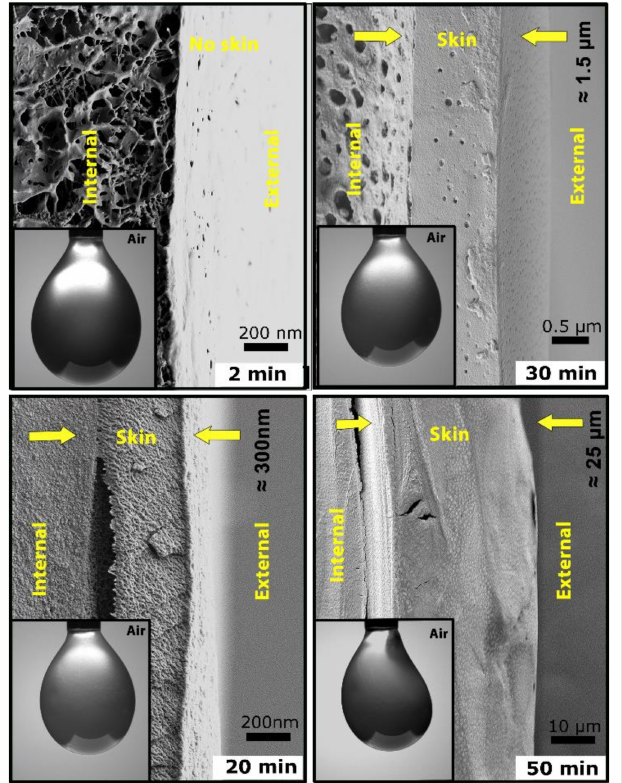
Figure 2. Self-assembly and evolution of skin at the water–air interface. SEM images of the cross- section of the pendant droplets of 2% w / v silk solution after 2 min, 20 min, 30 min, and 50 min. The skin layer is indicated in-between two yellow arrows for all images. For each time point, we have also included representative images of each pendant